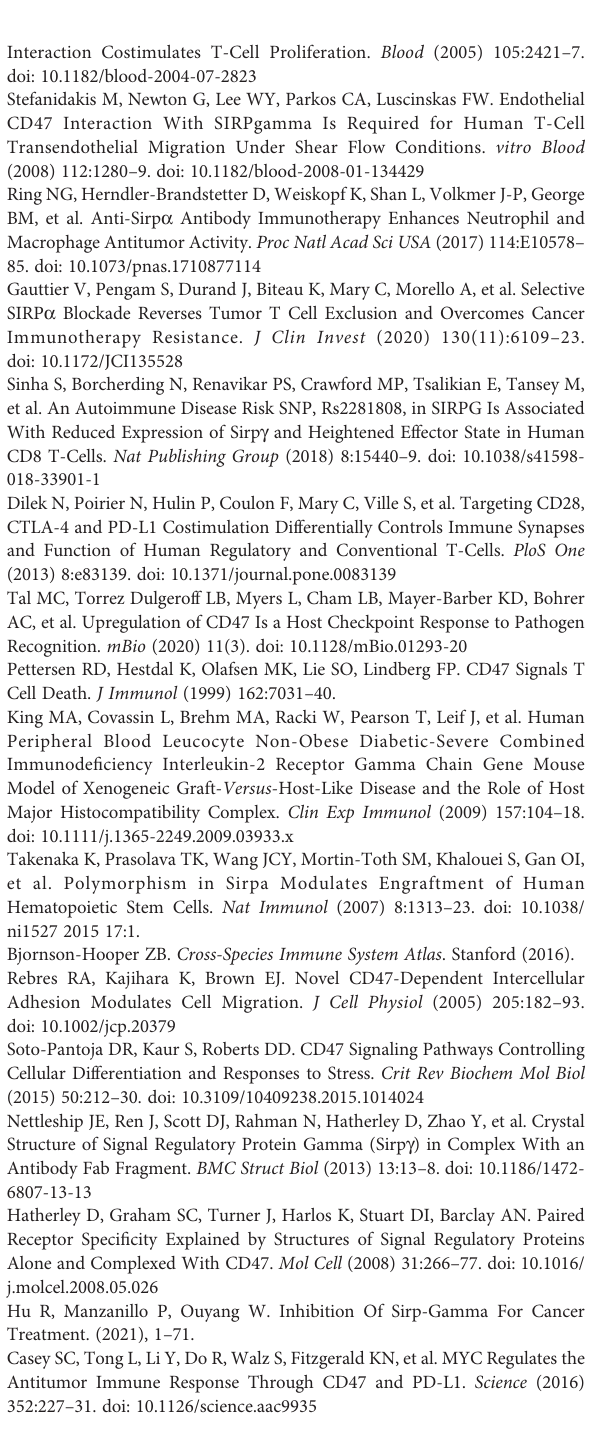
Supplementary Figure S3 | T-cell phenotype of human PBMC prior to their i.v. injection in NSG. PBMC from three HV were analyzed by FACS prior their i.v. injection in NSG-irradiated recipient mice. Percentage of CD4 (A) and CD8 (B) subpopulationsare presented based onFACS analysis with the followingpatterns